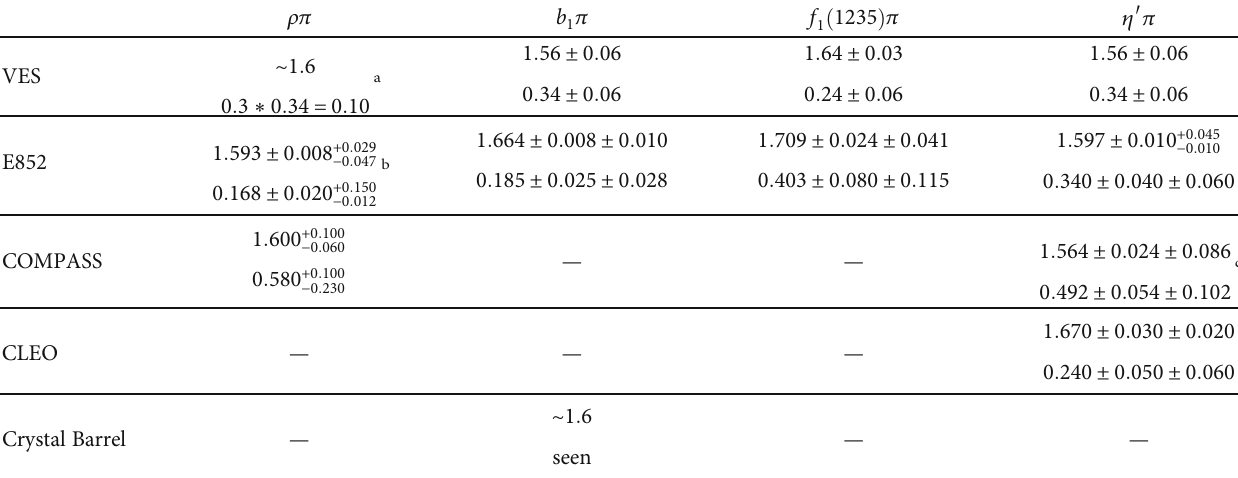
Table 1: The π ð 1600 Þ as seen in di ff erent experiments. The resonance masses and the corresponding decay widths are reported in 1